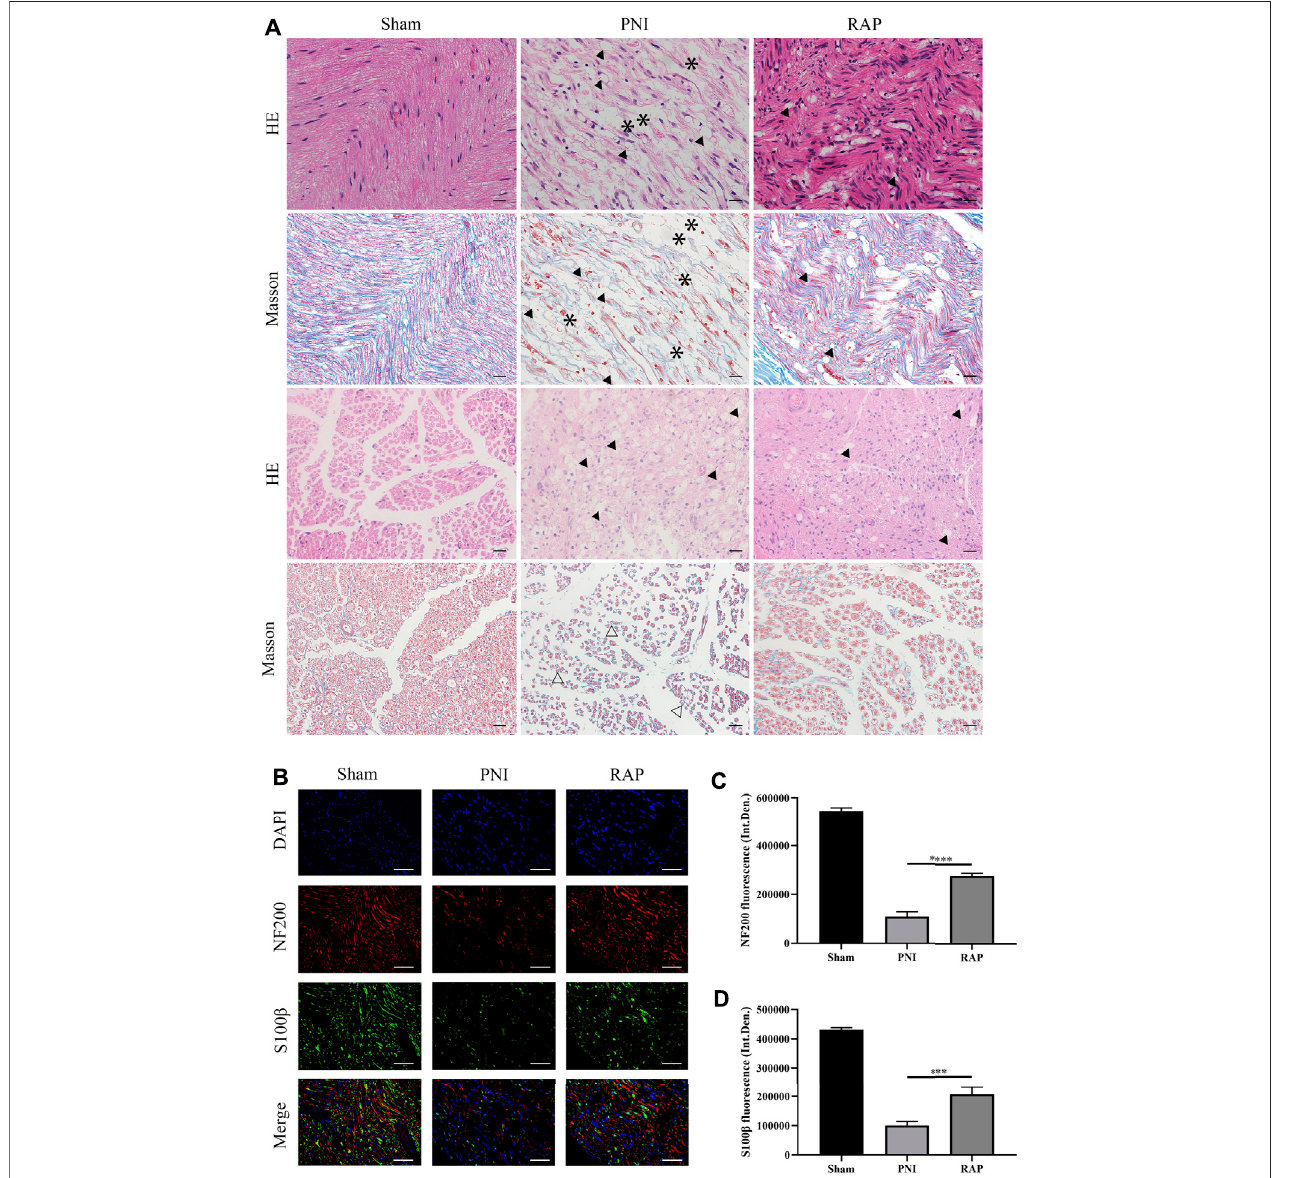
FIGURE 5 | RAP promoted axonal regeneration (A) Representative images of HE and Masson staining sciatic nerve longitudinal and transverse sections in each group28daysafter PNI(400×ampli fi cation, scalebar=20 μ m),arrowsshowvacuolization,asterisksshowinterruptednerves,hollowarrows showatrophicnerves; (B) Representative images of double immuno fl uorescence staining for NF200 (red) and S100 β (green) of sciatic nerve longitudinal sections in each group 28 days after PNI. Nuclei are stained with DAPI (blue) (400× ampli fi cation, scale bar = 50 μ m); (C) Statistical analysis of fl uorescence integrated density of NF200; (D) Statistical analysis of fl uorescence integrated density of S100 β . Data are presented as means ± SD. *** p < 0.001, **** p < 0.0001.